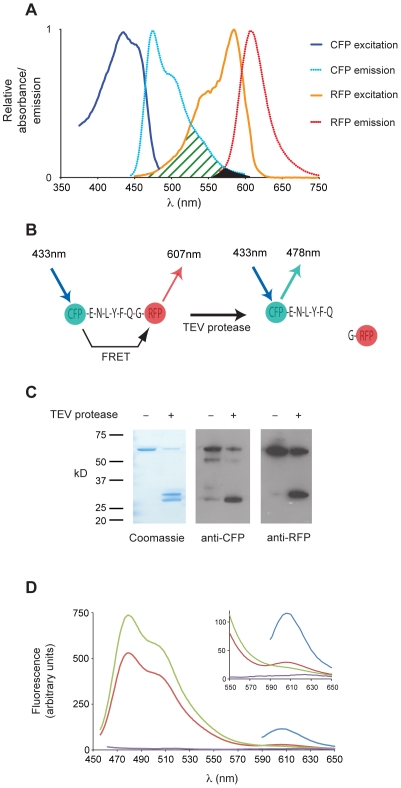
FRET between CFP and mRFP in solution.A. Absorbance and emission spectra of CFP and mRFP. The spectra are normalised to the excitation or emission maximum. The overlap (Jλ) between CFP emission and mRFP excitation is shown in green. The overlap in the emission spectra is shown in black. B. Schematic of the CFP-mRFP fusion protein. Before cleavage with TEV protease FRET can take place between CFP and mRFP resulting in energy from the excited CFP being transferred to the mRFP, diminishing the direct emission by CFP at 478 nm and stimulating emission of RFP at 607 nm. Following cleavage, energy transfer is lost resulting in an increase in 478 nm emission by CFP. C. Cleavage of the mRFP-TEV-CFP fusion protein by TEV protease. An aliquot of the reaction was taken from the spectrophotometer at the point at which the CFP emission peak had plateaued following addition of TEV protease. Aliquots were run on SDS-PAGE, stained with Coomassie Blue and transferred for Western blotting with anti-CFP and anti-RFP. D. FRET between CFP and mRFP. Spectra of the CFP-TEV-mRFP fusion protein before (red line) and after (green line) cleavage with TEV protease. The purple line shows the blank control and blue line the emission of the mRFP component of the fusion protein when directly excited at 584 nm.